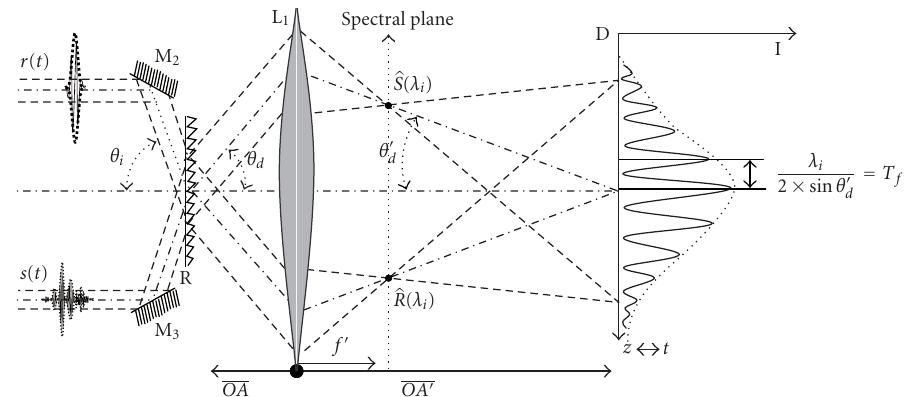
Figure 3: Parameters for correlator working